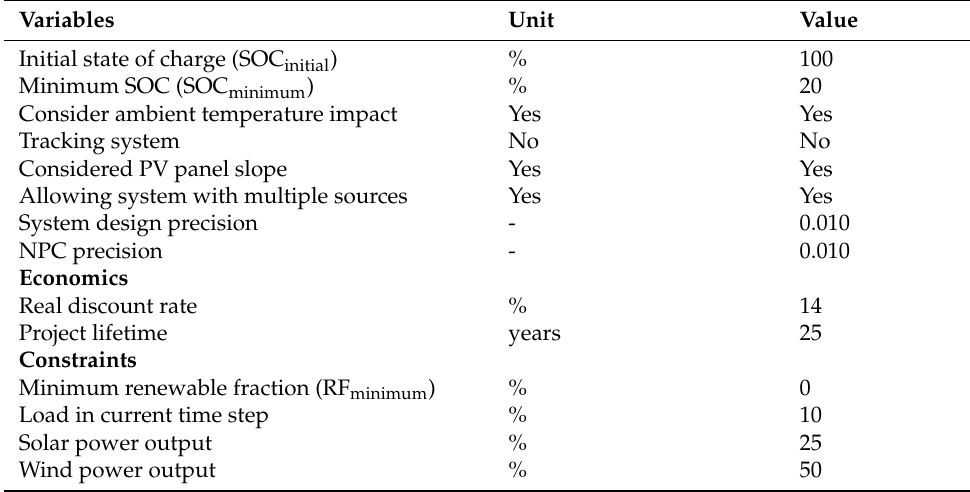
Table 4. The control variables, economics, and constraints utilized in the optimization tool [41,59,60].